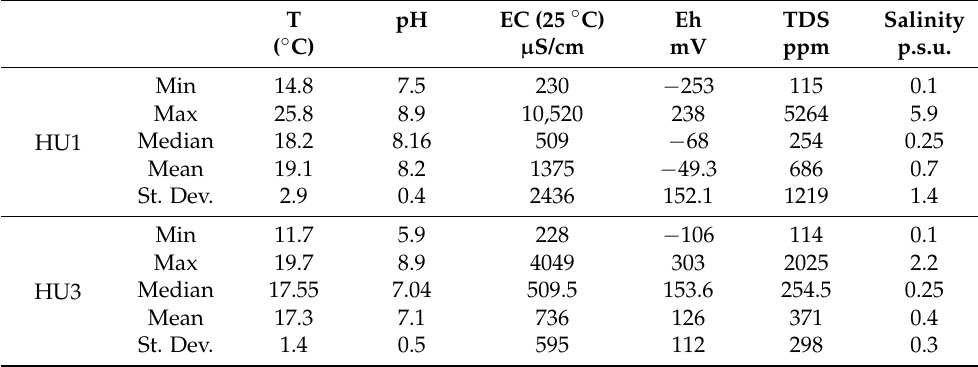
Table 2. The main statistical features of the physicochemical parameters of groundwater